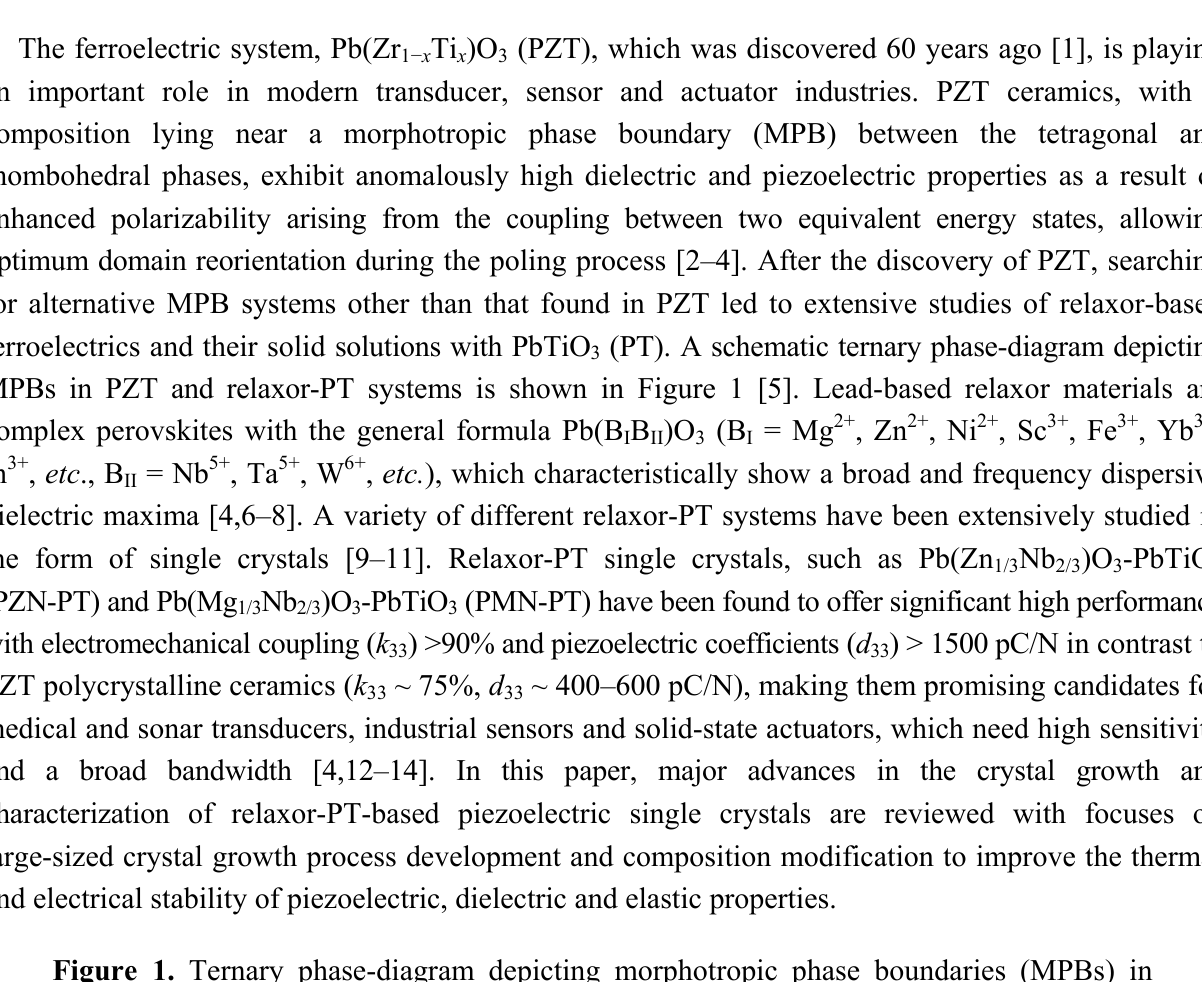
Figure 1. Ternary phase-diagram depicting morphotropic phase boundaries (MPBs) in Ti )O (PZT) and relaxor-PT systems. Reprinted with permission from Pb(Zr 1− x x 3